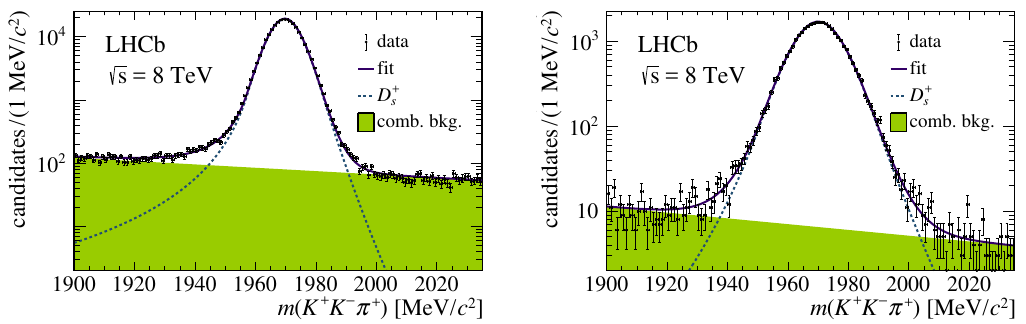
Figure 2 . Invariant mass distribution of the D + 2 : 0 < y < 3 : 0 and 2 : 5 < p T < 4 : 7 GeV =c , and (right) 3 : 5 < y < 4 : 5 and 8 : 5 < p T < 25 : 0 GeV =c p s = 8 TeV data set recorded with MagDown . Also shown is the result of the (cid:12)t, indicating for the the signal and combinatorial